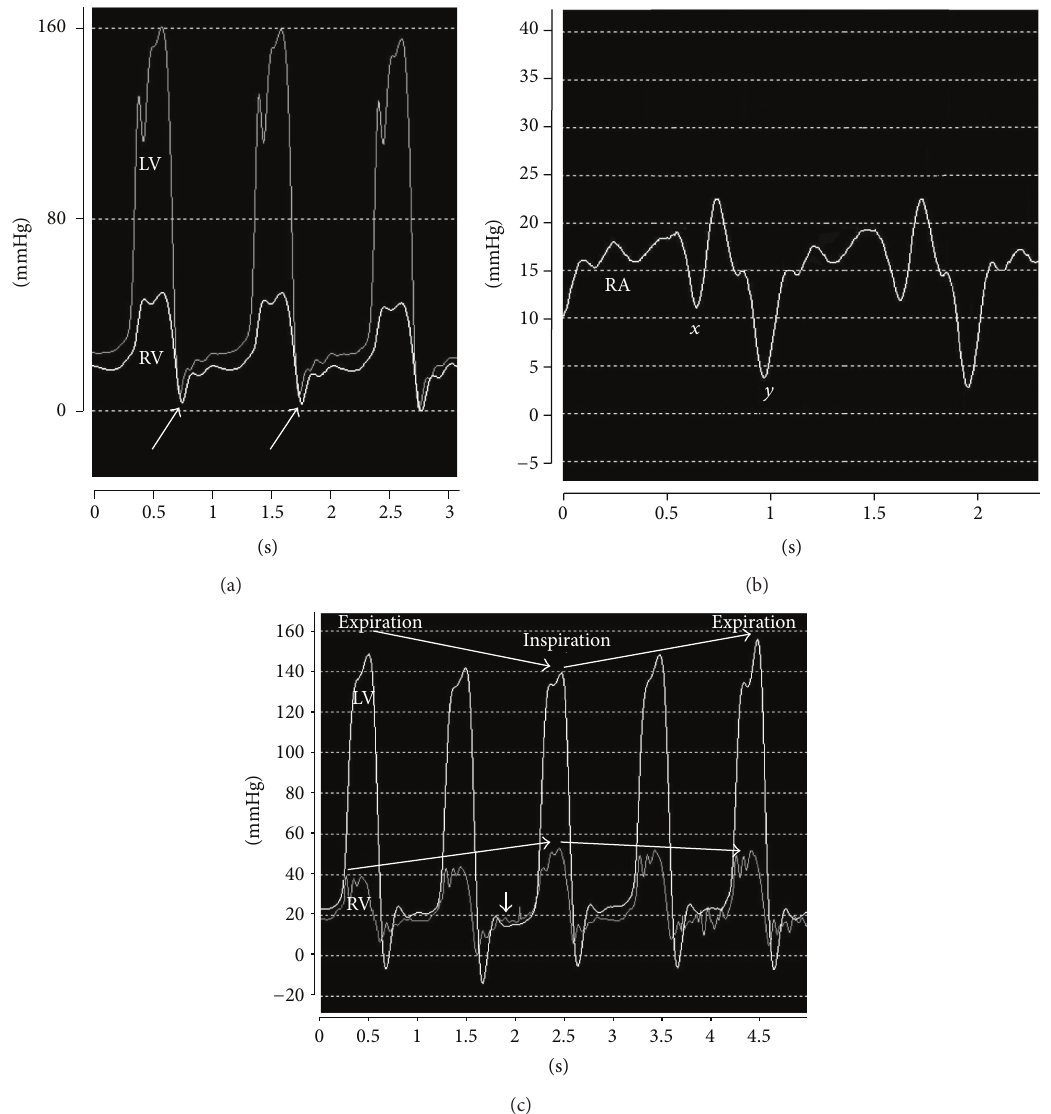
Figure 3: Cardiac catheterization findings of constrictive pericarditis. (a) Ventricular pressure tracings indicating a characteristic dip-and- plateau waveform (square root sign) (arrow). (b) Right atrial pressure tracing showing a prominent 𝑥 - and 𝑦 -descent (W sign). (c) Changes of ventricular pressure during respiration: increased right ventricular pressure with concordant decreased left ventricular pressure during inspiration. The opposite is found during expiration. Further, end-diastolic equalization of pressures in both ventricles is observed (arrow). RA denotes right atrium, RV right ventricle, and LV left